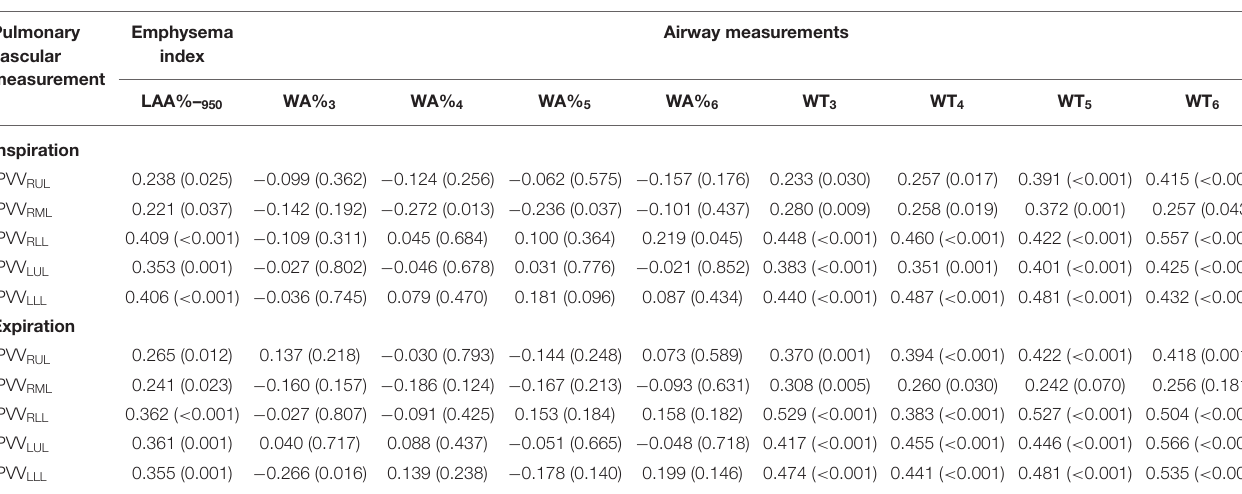
TABLE 4 | Correlations between IPVV and other